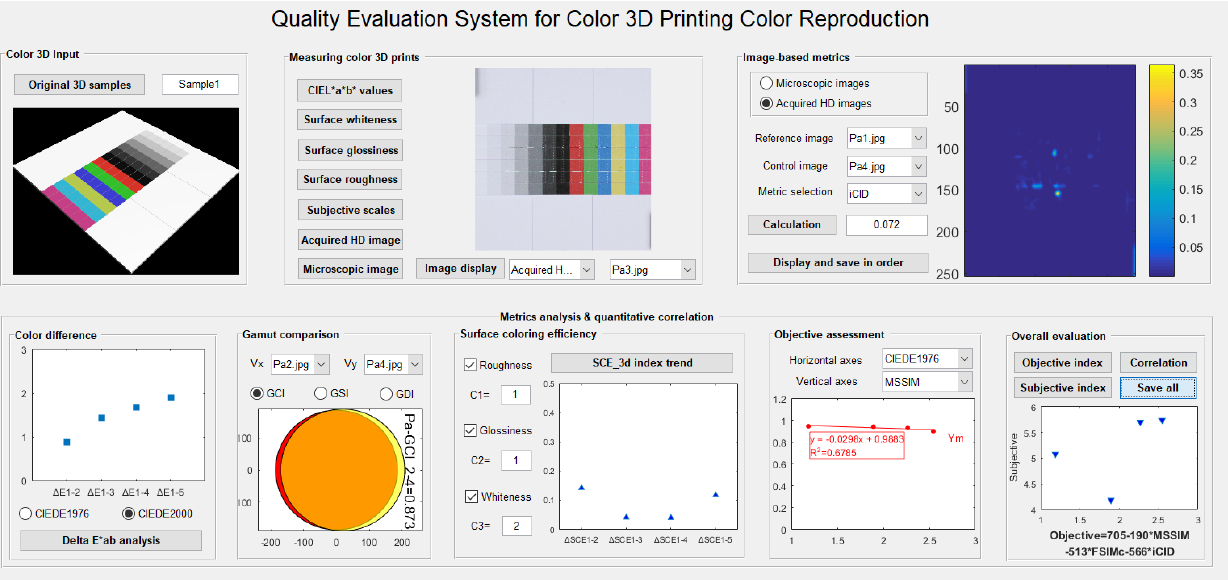
Figure 20. A test case of the current system based on Sample1 and real data in [26].